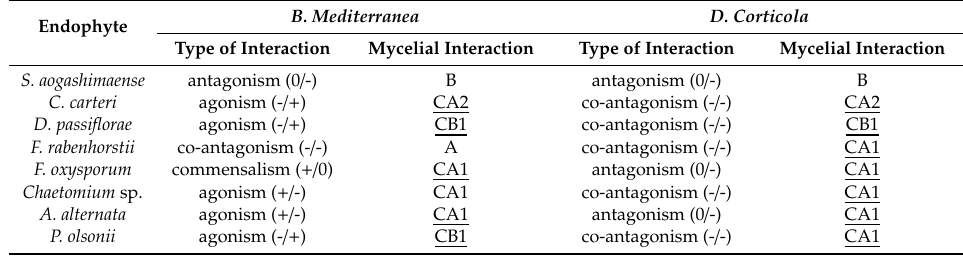
Table 3. Classification of fungal interactions occurring between tested endophytes and pathogens on dual-culture assay. The interaction type was classified based on endophyte/pathogen growth by “+“ for higher growth, “-“ for less growth and “0“ for equal growth in relation to control. Underlined mycelial interactions denote endophyte replacement by the pathogen.